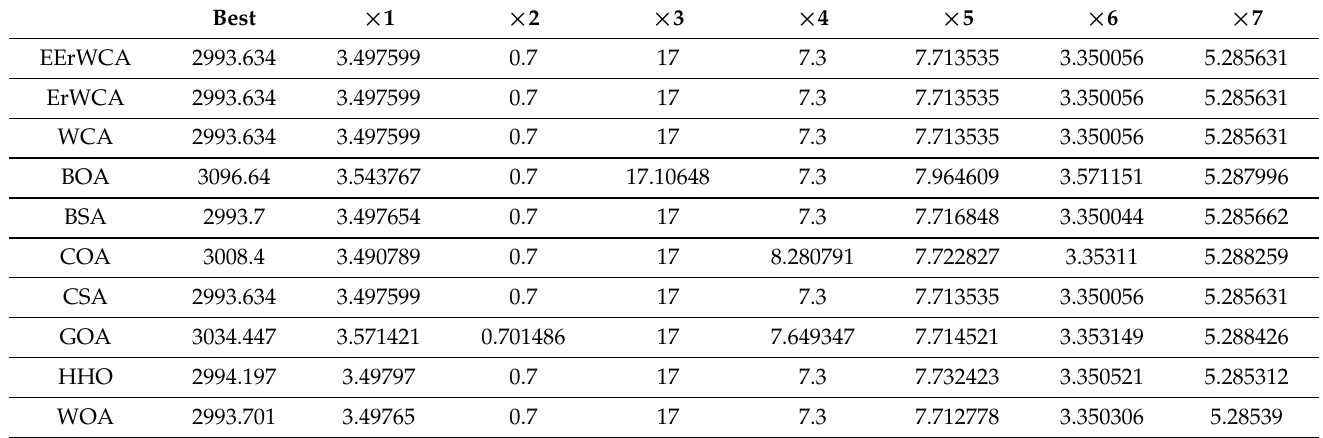
Table 8. Results of EErWCA versus other metaheuristics on speed reducer design.